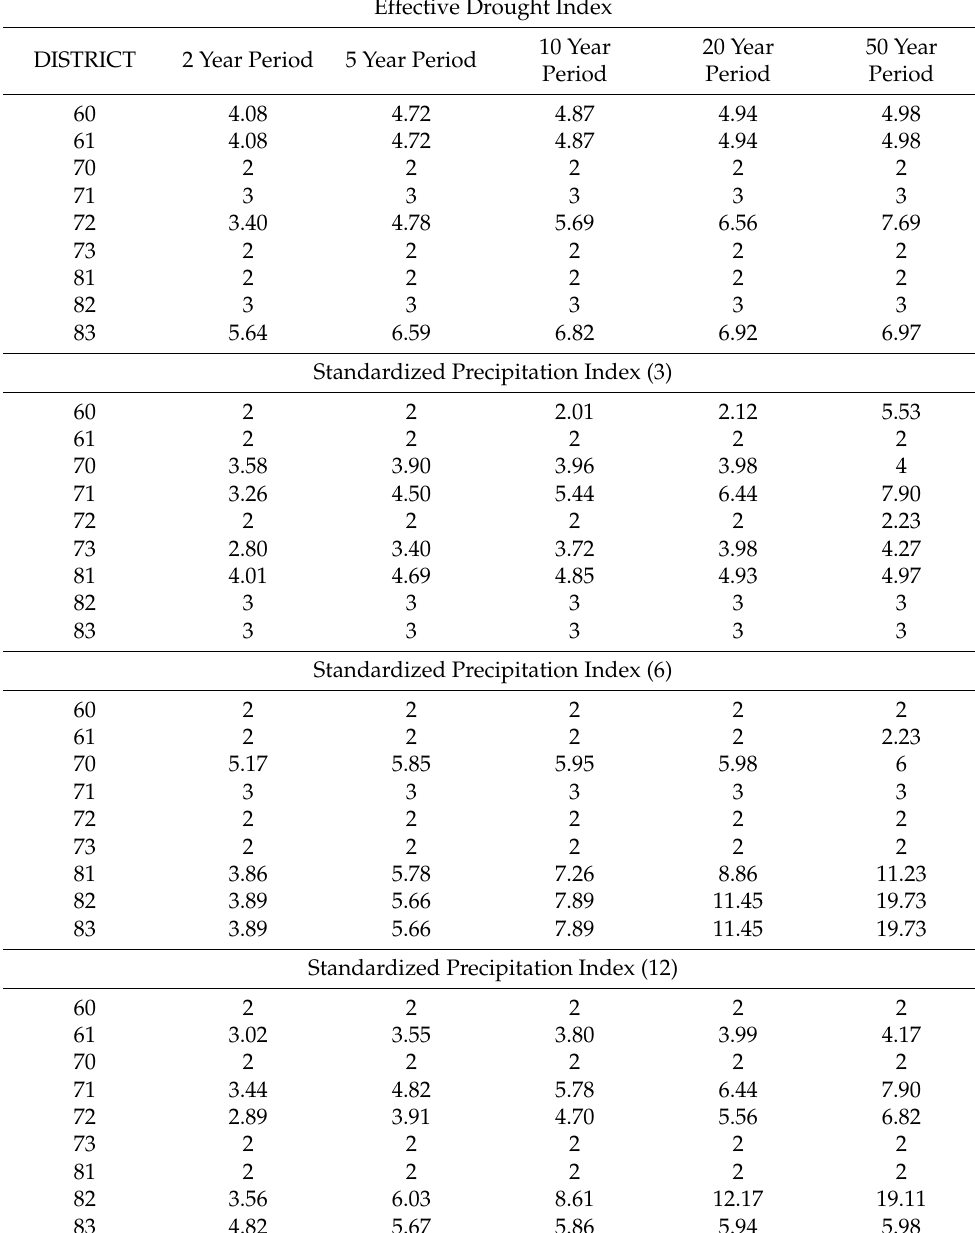
Table 2. The drought duration return levels for the 2-, 5-, 10-, 20-, and 50-year